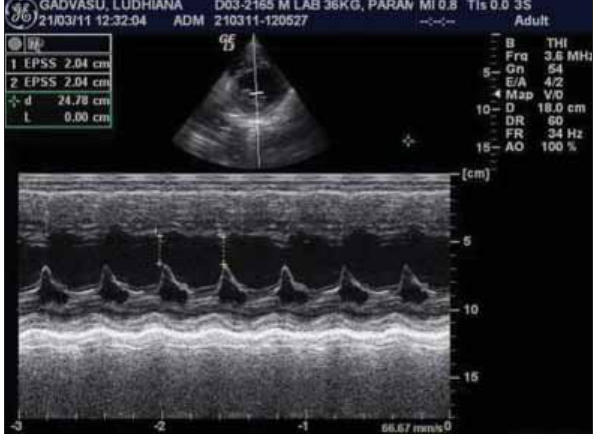
Figure-7: Anechoic column below the heart depicting increased volume of pericardial fluid.